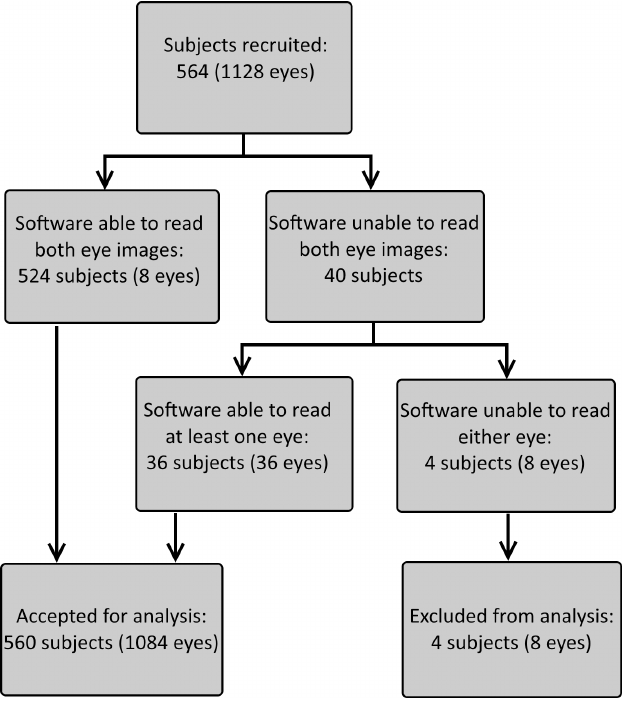
Fig 2. Flow chart showing recruitment, inclusion, and exclusion of subjects.